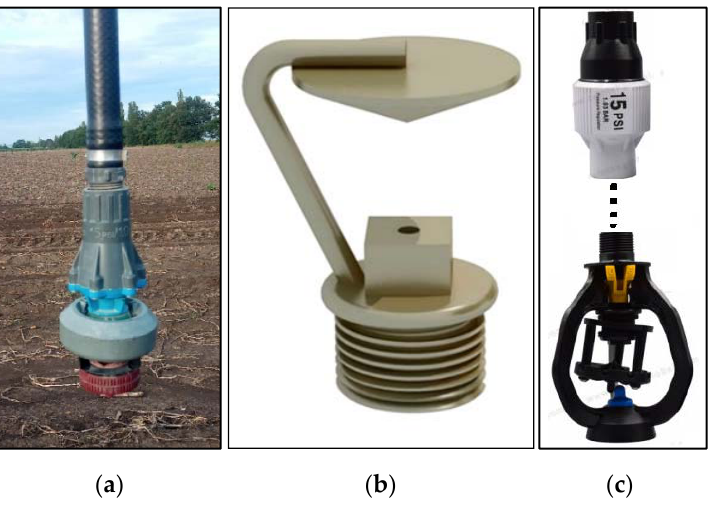
Figure 3. Sprayers on sprinklers, ( a ) T-L Pivot, linear—Nelson, ( b ) Fregat—Agref, ( c ) Bauer—I-Wob.